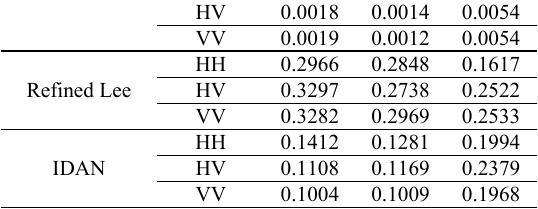
Table 3. EPD-ROA of filtered data Polarimetric information preservation